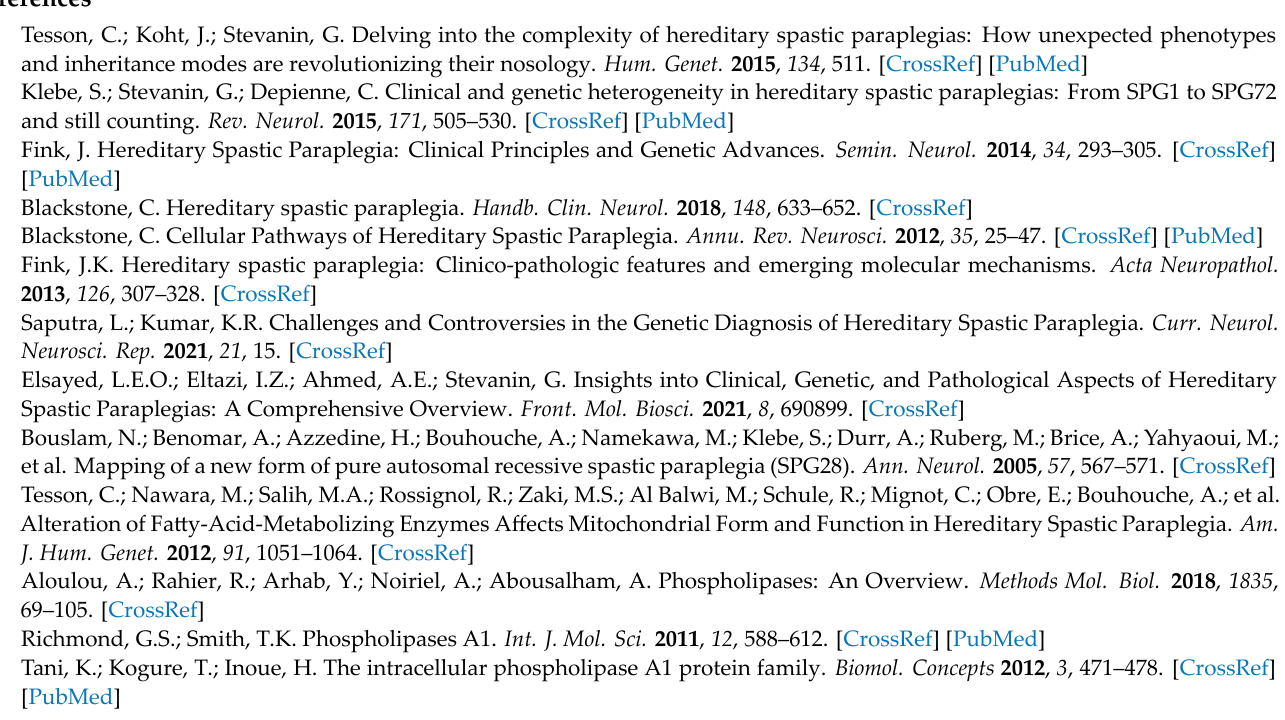
Table S1: PCs detected in mouse plasma; Table S2: PIs detected in mouse plasma; Table S3: PIs identified from mice plasma; Table S4: LPCs detected in mouse plasma; Table S5: LPIs detected in mouse plasma; Table S6; LPAs detected in mouse plasma; Table S7: LPAs identified from mice plasma; Table S8: Results in human sera for PIs significantly changed in Ddhd1 ( − / − ); Table S9: LPAs in human sera; Table S10: Oleic acid‑containing PIs in human